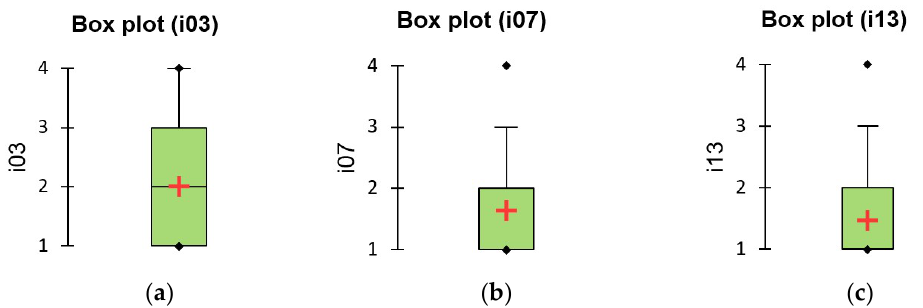
Figure 3. The most insufficient box plots: heritage, annexes, and assessment. ( a ) (i03 heritage); ( b ) (i07 annexes); ( c ) (i13 assessment).